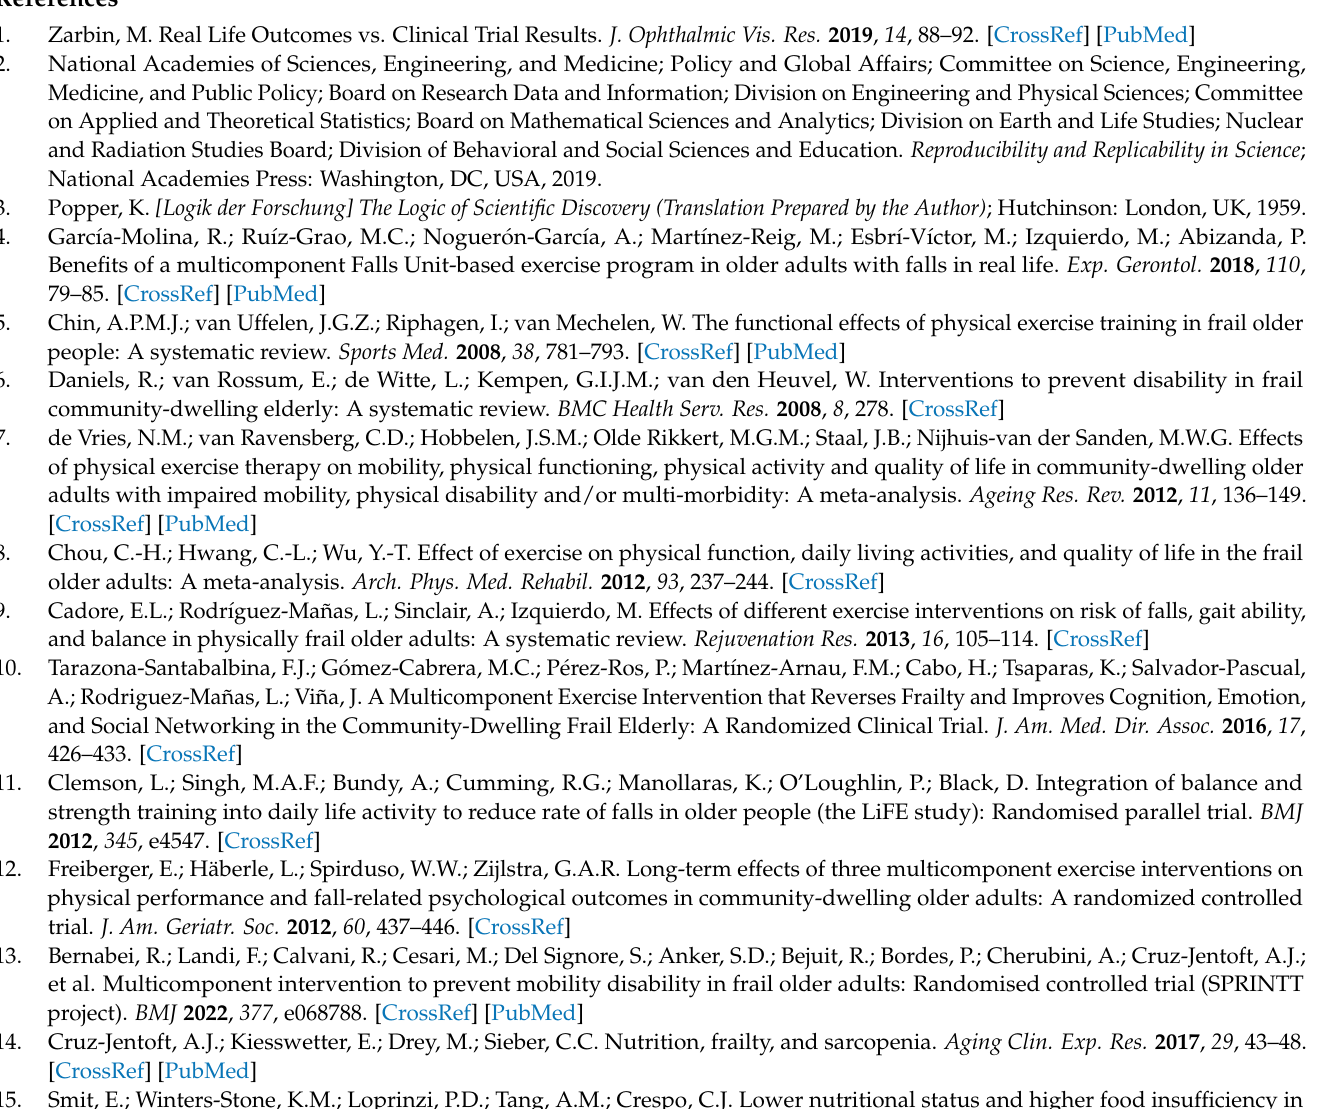
Figure A3. Anthropometric parameters in old individuals before and after a six-month intervention. ( a ) Fat mass. ( b )Lean mass. ( c ) Weight. Real-Life Intervention n = 50, Clinical Trial Intervention n = 51, Clinical Trial Control n = 49. Bars represent mean ± SD. Statistical analysis was performed with the Student’s t test for paired samples and the Wilcoxon test for non-parametric samples.